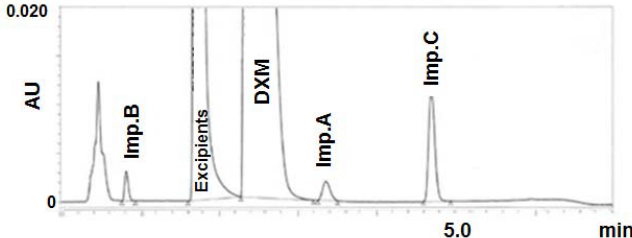
Figure 2. Reversed ‐ phase high ‐ performance liquid chromatography (RP ‐ HPLC) chromatogram of a mixture of dextromethorphan (DXM), its impurities, and excipients. Acquity BEH C18 column (50 × 2.1 mm i.d, 1.7 μ m). Gradient elution of ethanol (slope of 3.1%/min) with 10 mM ammonium formate adjusted at pH 4.7 with formic acid. Flow rate: 0.23 mL/min. Temperature: 38.0 °C. Detection at 280 nm. Similar to Reference [44].